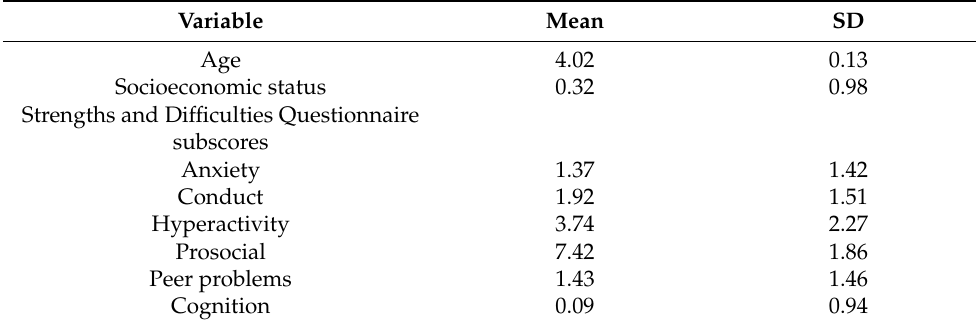
Table 2. Sample characteristics (continuous variables).